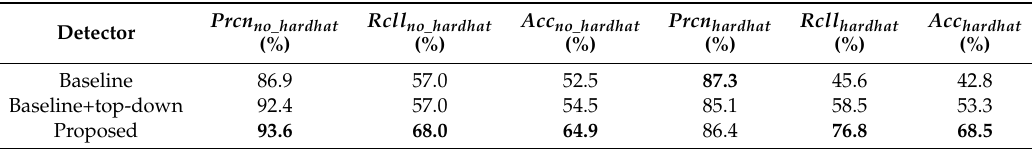
Table 5. Results comparison of different network architectures under the low-contrast condition (bold indicates either best performance or minimum